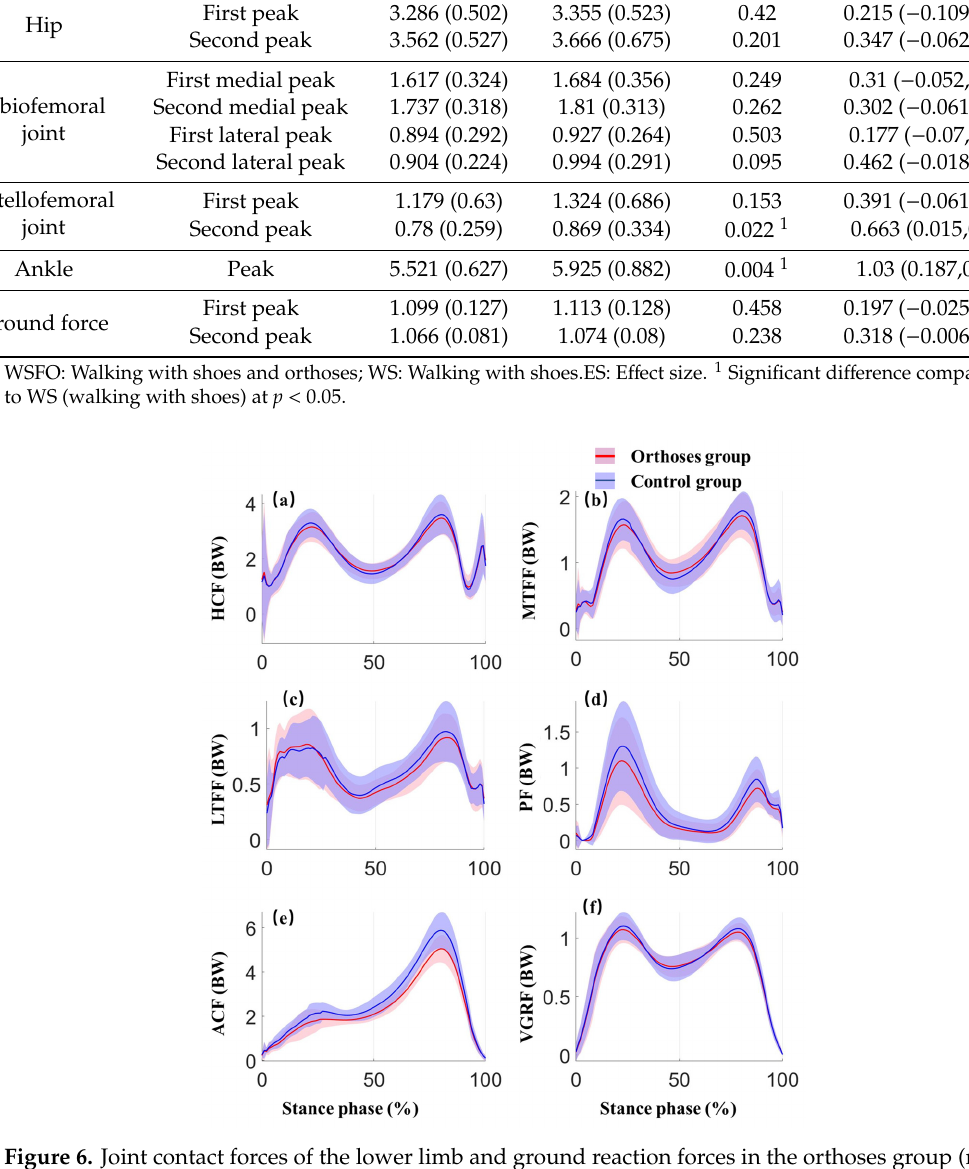
Figure 6. Joint contact forces of the lower limb and ground reaction forces in the orthoses group (red) and control group (blue) during stance phase. Shaded area ± 1 std ( a ) HCF: hip contact force ( b ) MTCF: medial tibiofemoral contact force ( c ) LTCF: lateral tibiofemoral contact force (d)PCF: patellofemoral contact force ( e ) ACF: ankle contact force ( f ) VGRF: Vertical ground reaction force.